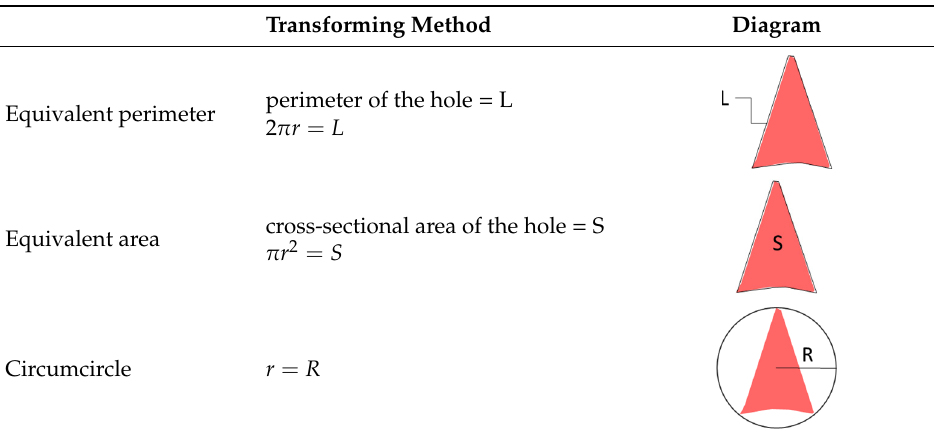
Table 3. Circle orifice diameter transforming method.